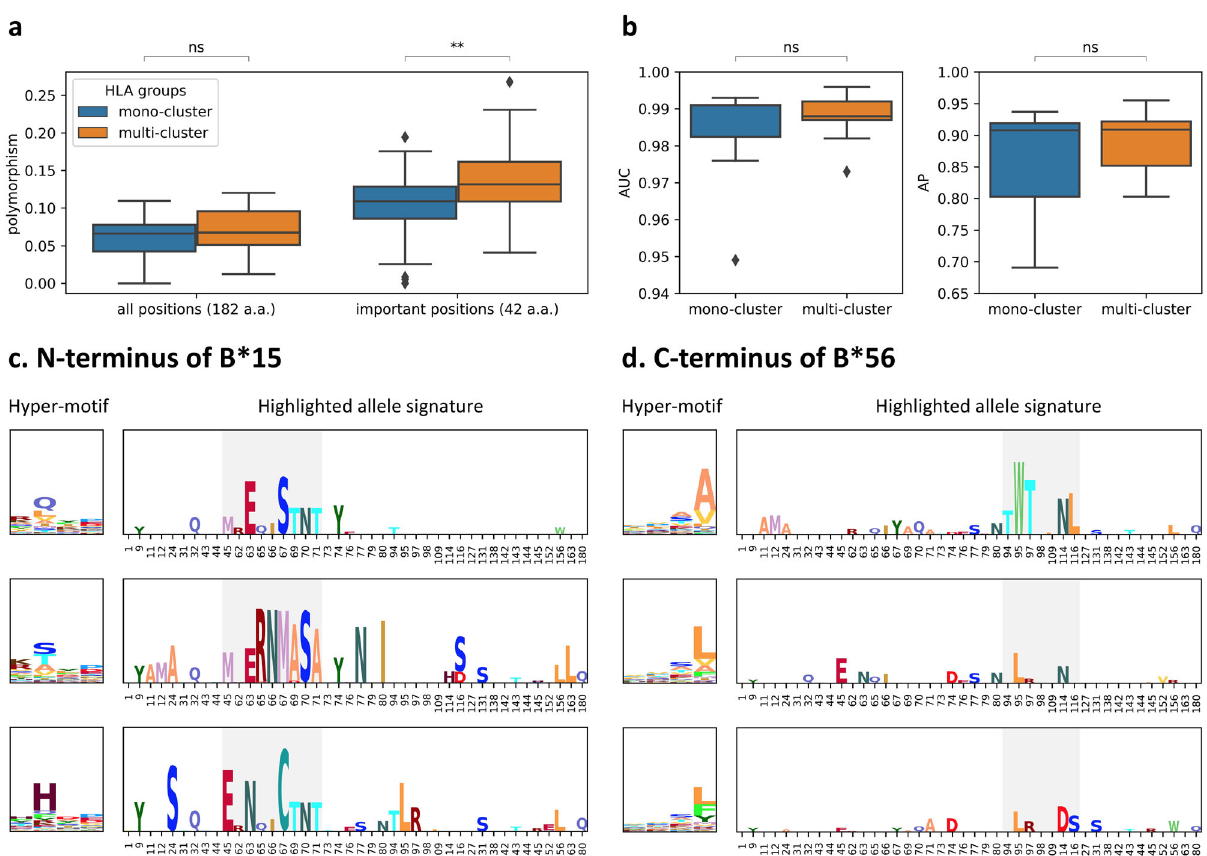
Fig. 6 Characteristics of the HLA groups falling into multiple sub-motif clusters. a Polymorphism on all 182 amino acids or the important positions of mono-cluster (group number = 44) or multi-cluster (group number = 27) HLA-groups. b AUC and AP of unobserved alleles grouped by mono-cluster (allele number = 7) or multi-cluster (allele number = 9) HLA-groups. c , d The hyper-motifs and highlighted allele signatures of the N-terminal sub-motif clusters of B*15 ( c ) and the C-terminal sub-motif clusters of B*56 ( d ). The box colored in gray is used to highlight the polymorphic sites. Boxplots depict the median value with a middle line, the 75th and 25th percentile upper and lower hinges, respectively, whiskers with 1.5× interquartile ranges, and points as outliers. P values (two-tailed independent t test) are shown as “ ns ” no signi fi cance and ** P ≤ 0.01. Source data and details of the statistical analysis are provided in Supplementary Data 9 and